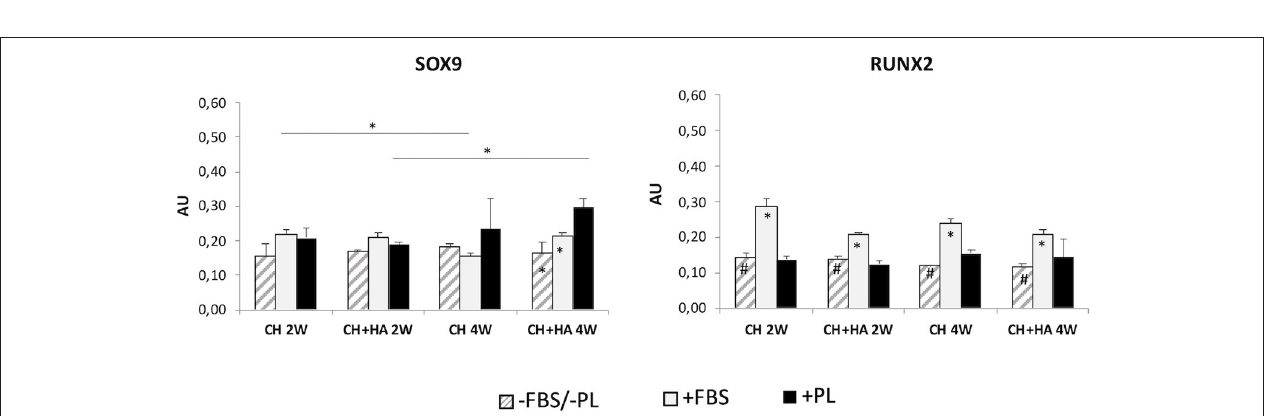
FIGURE 7 | Gene expression of Sox9 and Runx2 in chondrocytes cultured in chitosan scaffolds (CH) and chitosan scaffolds prepared with hyaluronic acid (CH + HA) after 2 and 4 weeks in different conditions (–FBS/–PL, + FBS, + PL). Statistical analysis: asterisks above the horizontal lines indicate significant differences of condition during time and among materials (* P < 0.05). Within each material, asterisk indicates significant differences vs. PL and hashtag (#) indicates significant differences vs. FBS ( n =